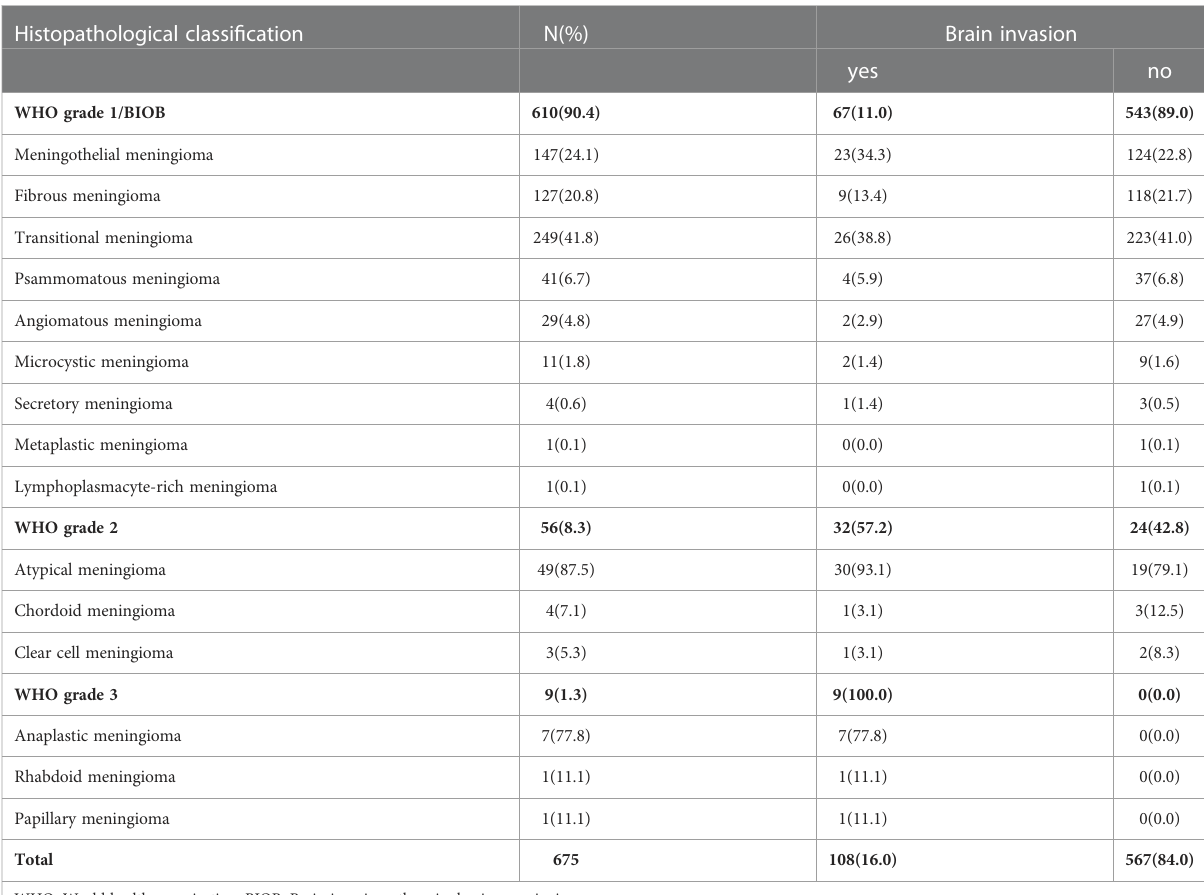
TABLE 1 Histopathological classi fi cation of meningioma